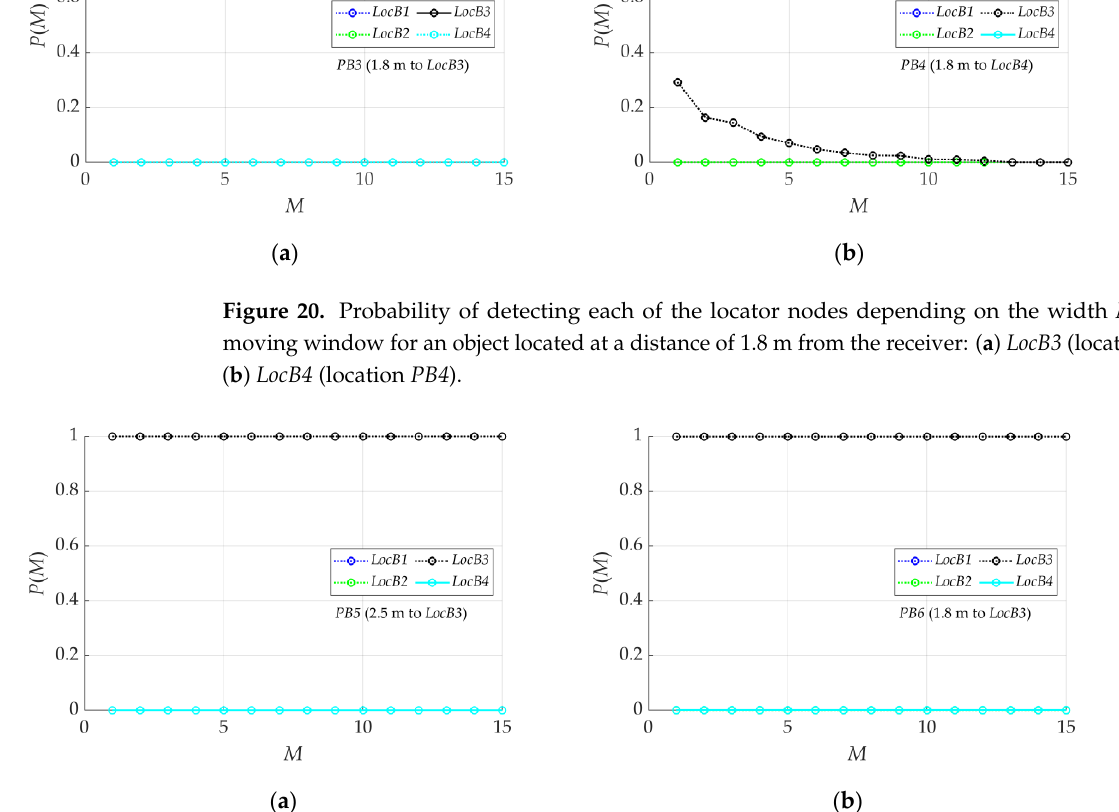
Figure 21. Probability of detecting each of the locator nodes depending on the width M of the moving window for an object placed in front of the LocB3 receiver at a distance of ( a ) 2.5 m (location PB5 ); ( b ) 1.0 m (location PB6 ).